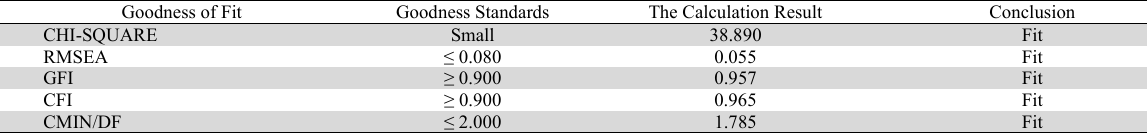
Fig. 3. The results of running the latent variable HRD Planning The Goodness of Fit - The HRD Planning –SEM